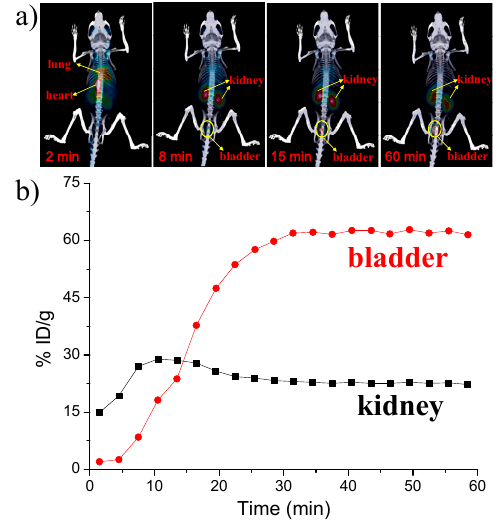
Figure 7. ( a ) Representative microPET-CT images of BALB/c mice at different times after intravenous injection of 64 Cu-doped Cu(I)-GSH complex; ( b ) Time-dependent kidney and bladder biodistribution of 64 Cu-doped Cu(I)-GSH complex, the target activity was calculated as percentage injected dose per gram (%ID/g), which is defined as (activity (mCi/mL))/(total injected dose (mCi))/density, (assuming density = 1 g/mL).